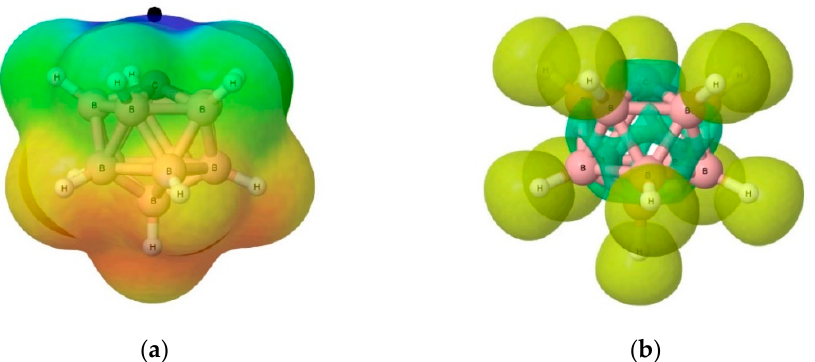
Figure 5. Electronic structure of carbonium ylide ( 1 ) CB 11 H 11 : ( a ) Molecular electrostatic potential V( r ). Red colour for V( r ) < − 0.015 au, Blue colour for V( r ) > 0.03 au. The black dot indicates the localization of the π -hole (0.061 au), and ( b ) Electron Localization Function (ELF) with an isosurface of ELF = 0.75. Computations with the G4MP2 level of theory.